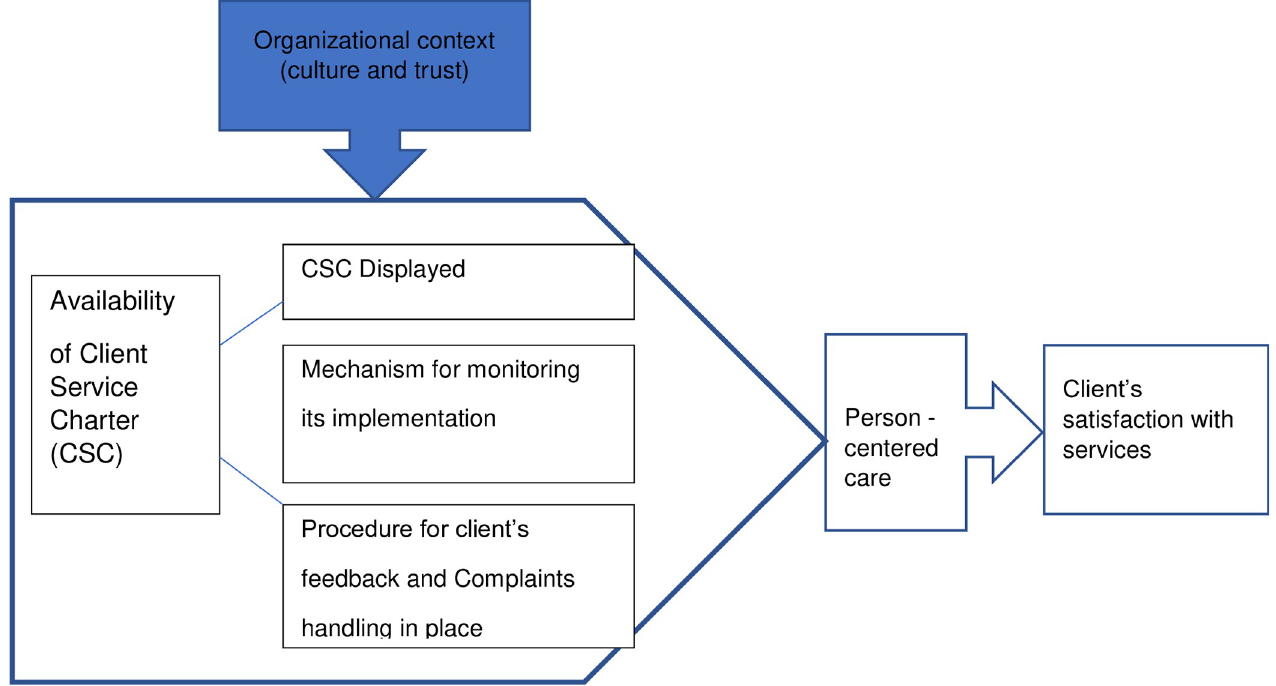
Fig 1. Conceptual framework for implementation of client service charter in health facilities.